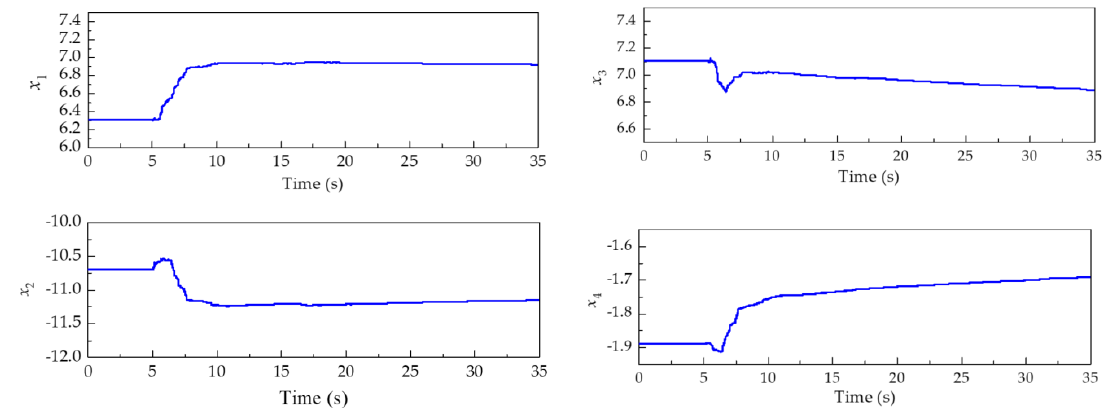
Figure 11. Displacement time histories of the first floor for Case 1. ( a ) Overview; ( b ) Enlarged view.